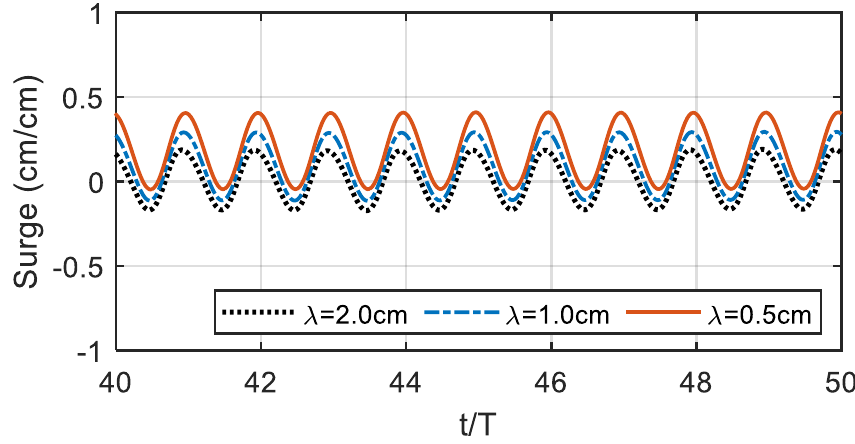
Figure 7. Variations in the surge motion for the platform with various fishnet mesh sizes ( H = 4 cm, T = 0.91 s, and σ 2 h / g = 3.9).